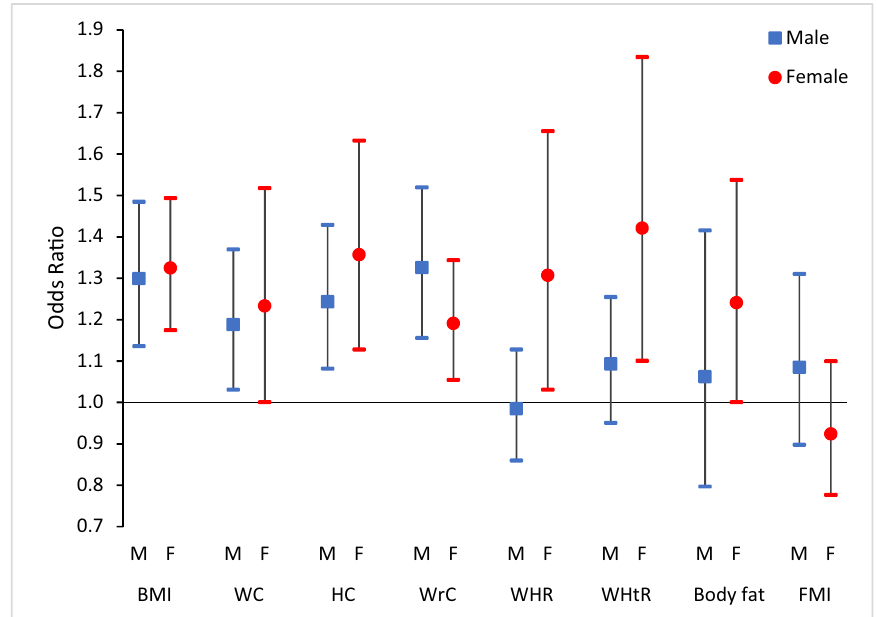
Figure 2. The odds ratios of multivariate model of binary logistic regression between sleep and anthropometric data, body fat percentage and fat mass index as binary outcomes in both genders. BMI = Body Mass Index, WC = Waist Circumferences, HC = Hip Circumferences, WrC = Wrist Circumferences, WHR = Waist to Hip Ratio, WHtR = Waist to Height Ratio, FMI = Fat Mass Index. Multivariate model: adjusted with age, physical activity and dietary intake. Sleep considered as a binary variable in the model (Sleep hours < 8 =